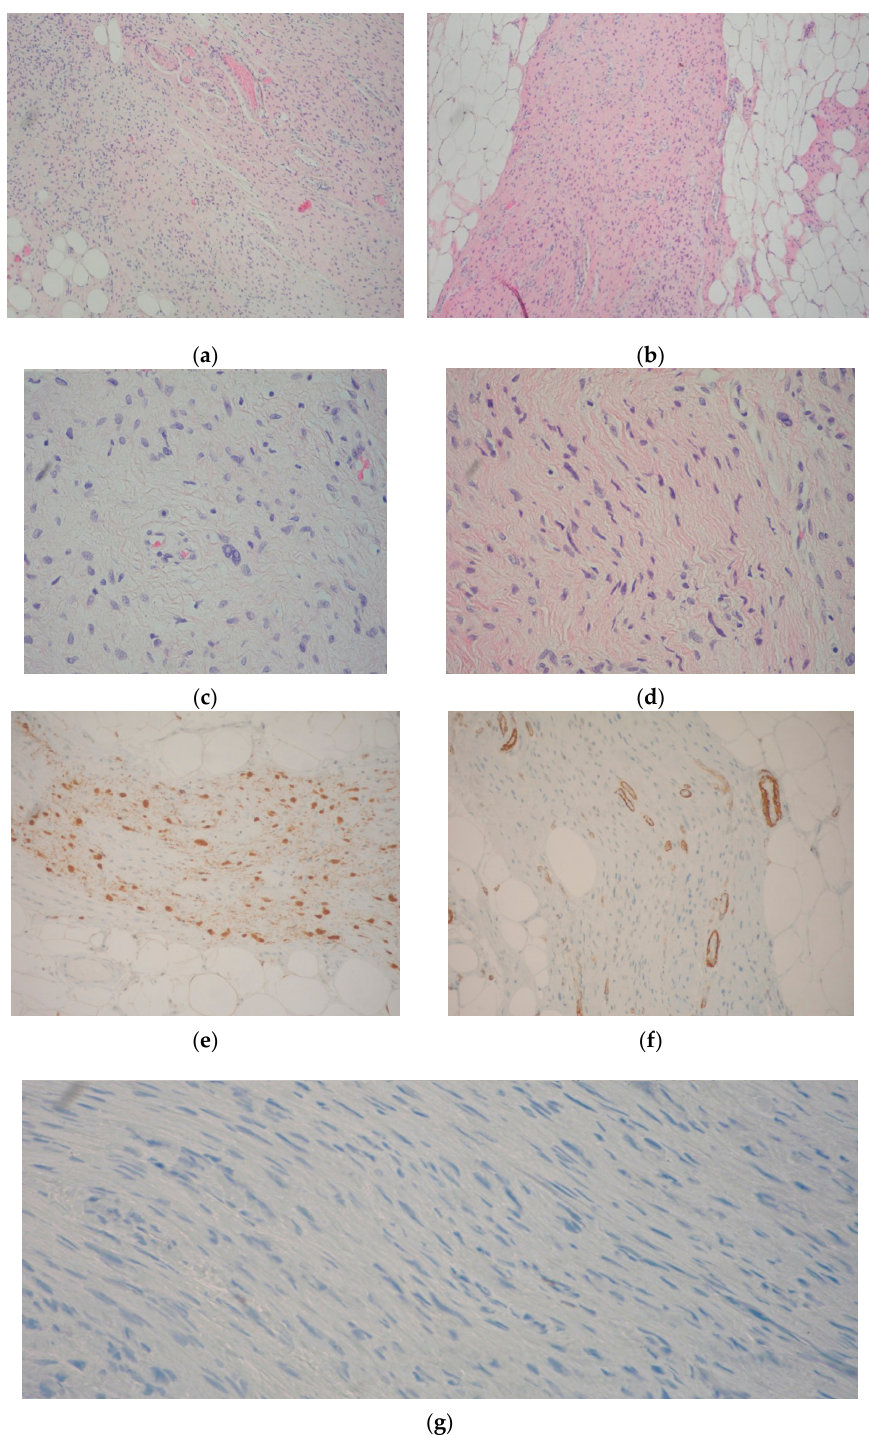
Figure 1. Neurofibroma resection specimen. ( a , b ) Spindle “wavy” cells in a matrix of fine fibrillary collagen; neurofibromatous tissue merges with mature fat and ectatic vessels (Hematoxylin-eosin, Magnification 10×); ( c , d ) Spindle cell nuclei in a fine fibrillary matrix, at a greater magnification (Hematoxylin-Eosin, Magnification 40×); ( e ) S100 immunohistochemical test confirmed the neurogenic origin of the lesion (Magnification 20×); ( f ) Actin-hhf35 immunohistochemical test excluded the myogenic origin of the lesion (note that only perivascular splindle smooth cells were reactive) (Magnification 20×); ( g ) Proliferation index by Ki67 immunohistochemical test was almost negative (Magnification 20×).